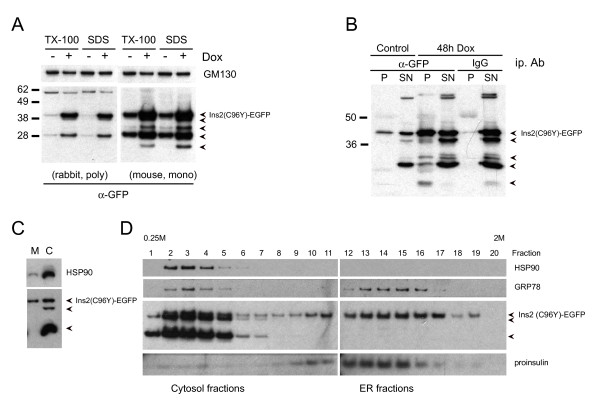
Insulin 2 (C96Y)-EGFP is localized to the ER while degradation products appear in the cytosol. A. Clone #4S2 cells were untreated (-Dox) or treated with 2 μg/ml doxycycline (+Dox) for 48 h. Following the treatments, the cells were washed in PBS and lysed in either 1% TX-100 lysis buffer (with protease inhibitors) or directly in SDS sample buffer with β-mercaptoethanol. Equal amounts of protein (or equal volumes) were resolved by SDS-PAGE and immunoblotted using antibodies to GM130 or GFP. B. Cells were untreated (Control) or treated for 48 h with 2 μg/ml doxycycline before lysis and immunoprecipitation with anti-GFP or control mouse IgG antibodies. The entire precipitate (pellets; P) and 10 μg of the supernatant (SN) were resolved by SDS-PAGE and immunoblotted using an anti-GFP (rabbit, polyclonal) antibody. C. Cells were treated with 2 μg/ml doxycycline for 72 h, washed in PBS and homogenized in sucrose buffer as described in the methods. The homogenate was fractionated into membrane (M) and cytosol (C) fractions. D. Cells were treated with 2 μg/ml doxycycline for 72 h, washed in PBS and homogenized in sucrose buffer as described in the methods. The homogenate was fractionated on a linear sucrose density gradient and an equal volume of each fraction was resolved by NuPAGE and immunoblotted using antibodies to HSP90, GRP78, GFP and insulin.